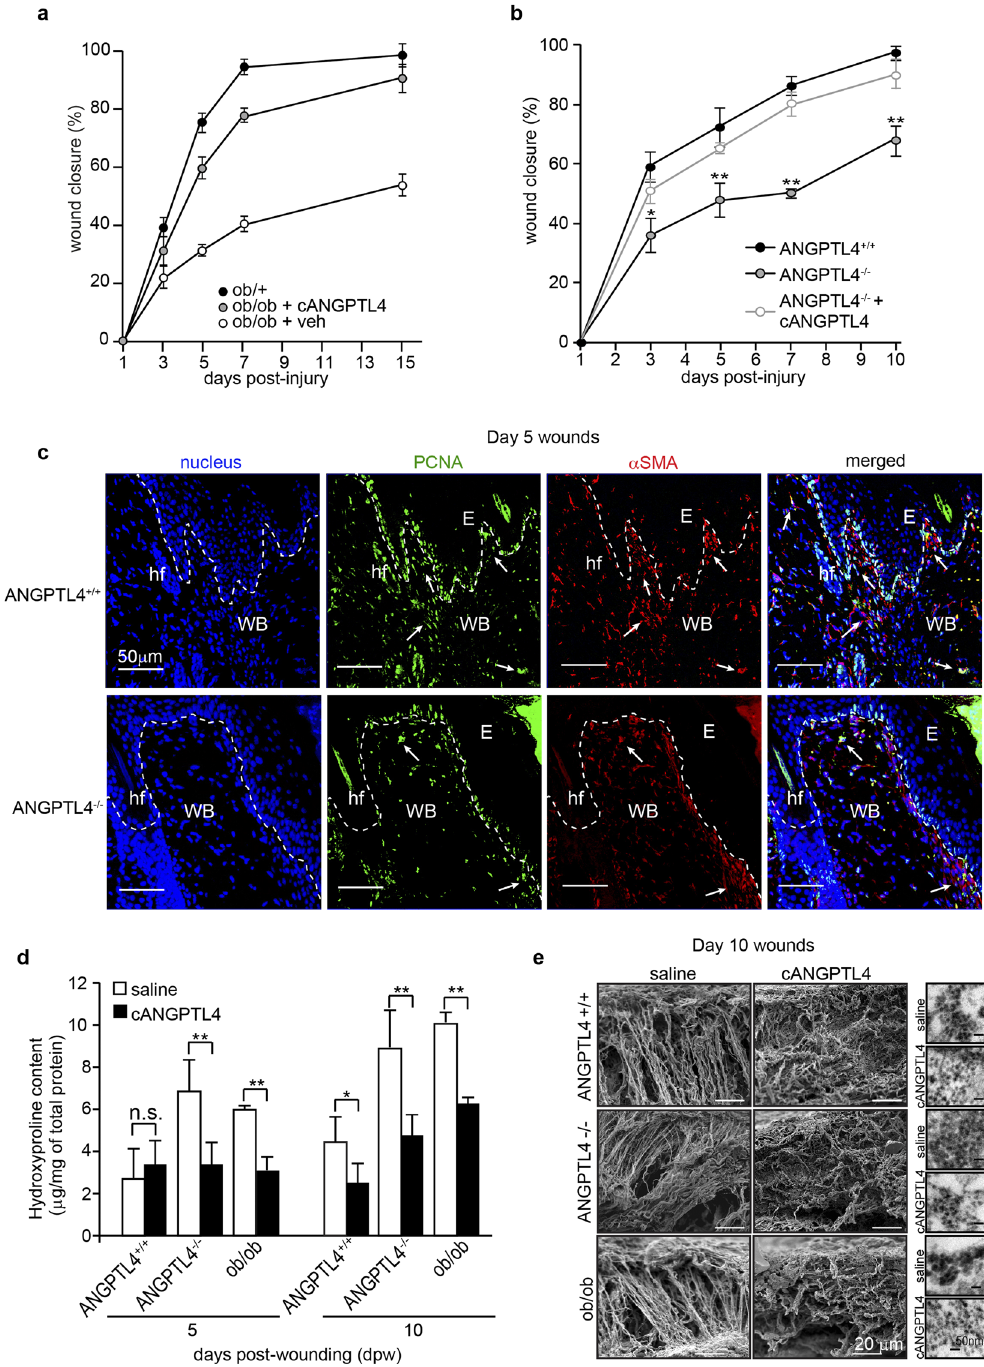
Figure 1. cANGPTL4 accelerates wound closure, modifies wound collagen expression and architecture, and improves the biomechanical quality of healed skin. ( a ) Wound closure rates of saline (veh) or cANGPTL4- treated ob/ob mice wounds and non-diabetic ob/ + mice wounds. Mice were inflicted with a 5 mm full- thickness excisional skin wound exposing the lower dermis. Recombinant cANGPTL4 protein or saline in 4% carboxymethylcellulose hydrogel was topically applied to the wounds (~6.25 µ g/25 g body weight/day) and protected with an occlusive dressing (Tegaderm ™ ; 3 M, USA). Wound dimensions were measured at the indicated time points before mice were sacrificed for histology and protein analysis of wounds. ( b ) Wound closure rates of saline-treated or cANGPTL4-treated wounds from ANGPTL4 + / + , ANGPTL4 − / − mice. Wounds were treated with saline or cANGPTL4 and measured accordingly as stated in ( a ). ( c ) Immunofluorescence staining of day 5 wounds from ANGPTL4 + / + and ANGPTL4 − / − mice. Day 5 was chosen as a reference time point because the wound healing rate was exponential. The dotted line indicates the epidermis-dermis junction. PCNA staining in green identifies proliferating cells within the wound bed (WB). α SMA staining in red identifies wound fibroblasts. Arrows denote proliferating wound fibroblasts. E: epidermis; hf: hair